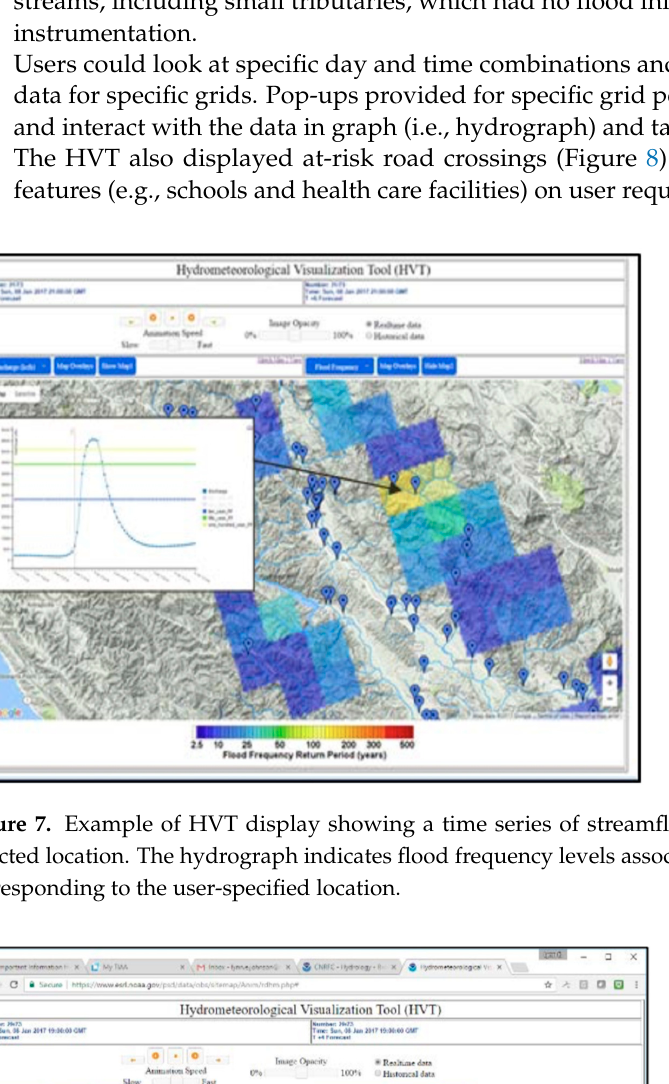
Figure 7. Example of HVT display showing a time series of streamflow (hydrograph) at a user selected location. The hydrograph indicates flood frequency levels associated with the grid element corresponding to the user-specified location.